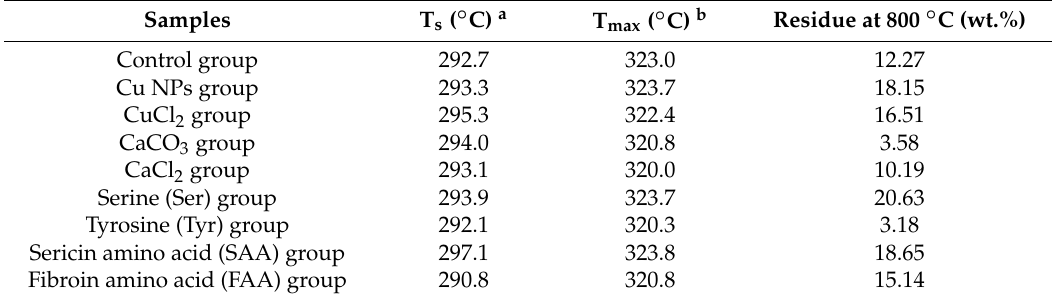
Table 2. Typical degradation temperatures and residue masses of the silk fibers at 800 ◦